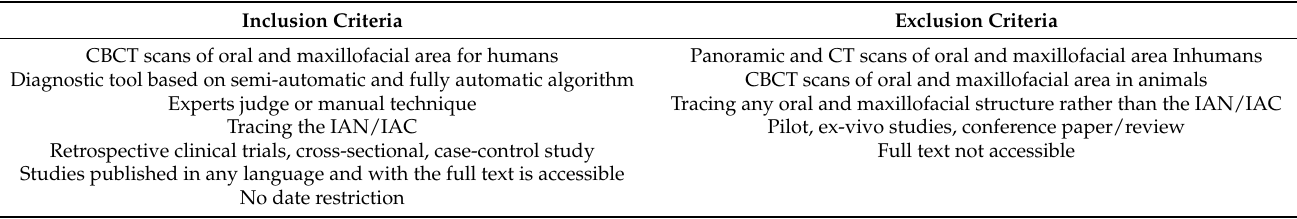
Table 1. Table of Inclusion and Exclusion Criteria. Inclusion Criteria Exclusion Criteria CBCT scans of oral and maxillofacial area for